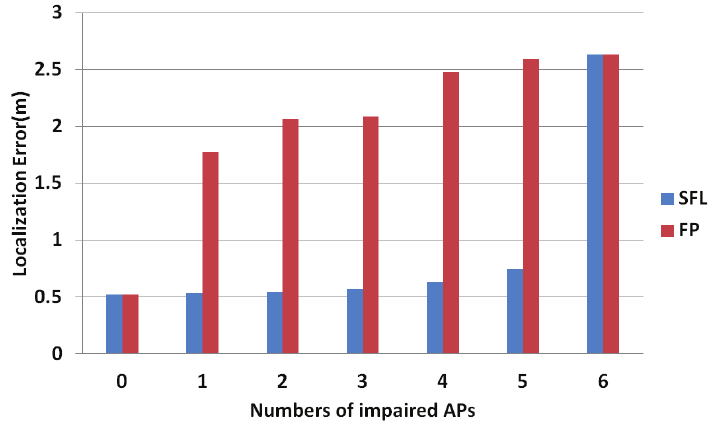
Figure 12. Algorithm positioning